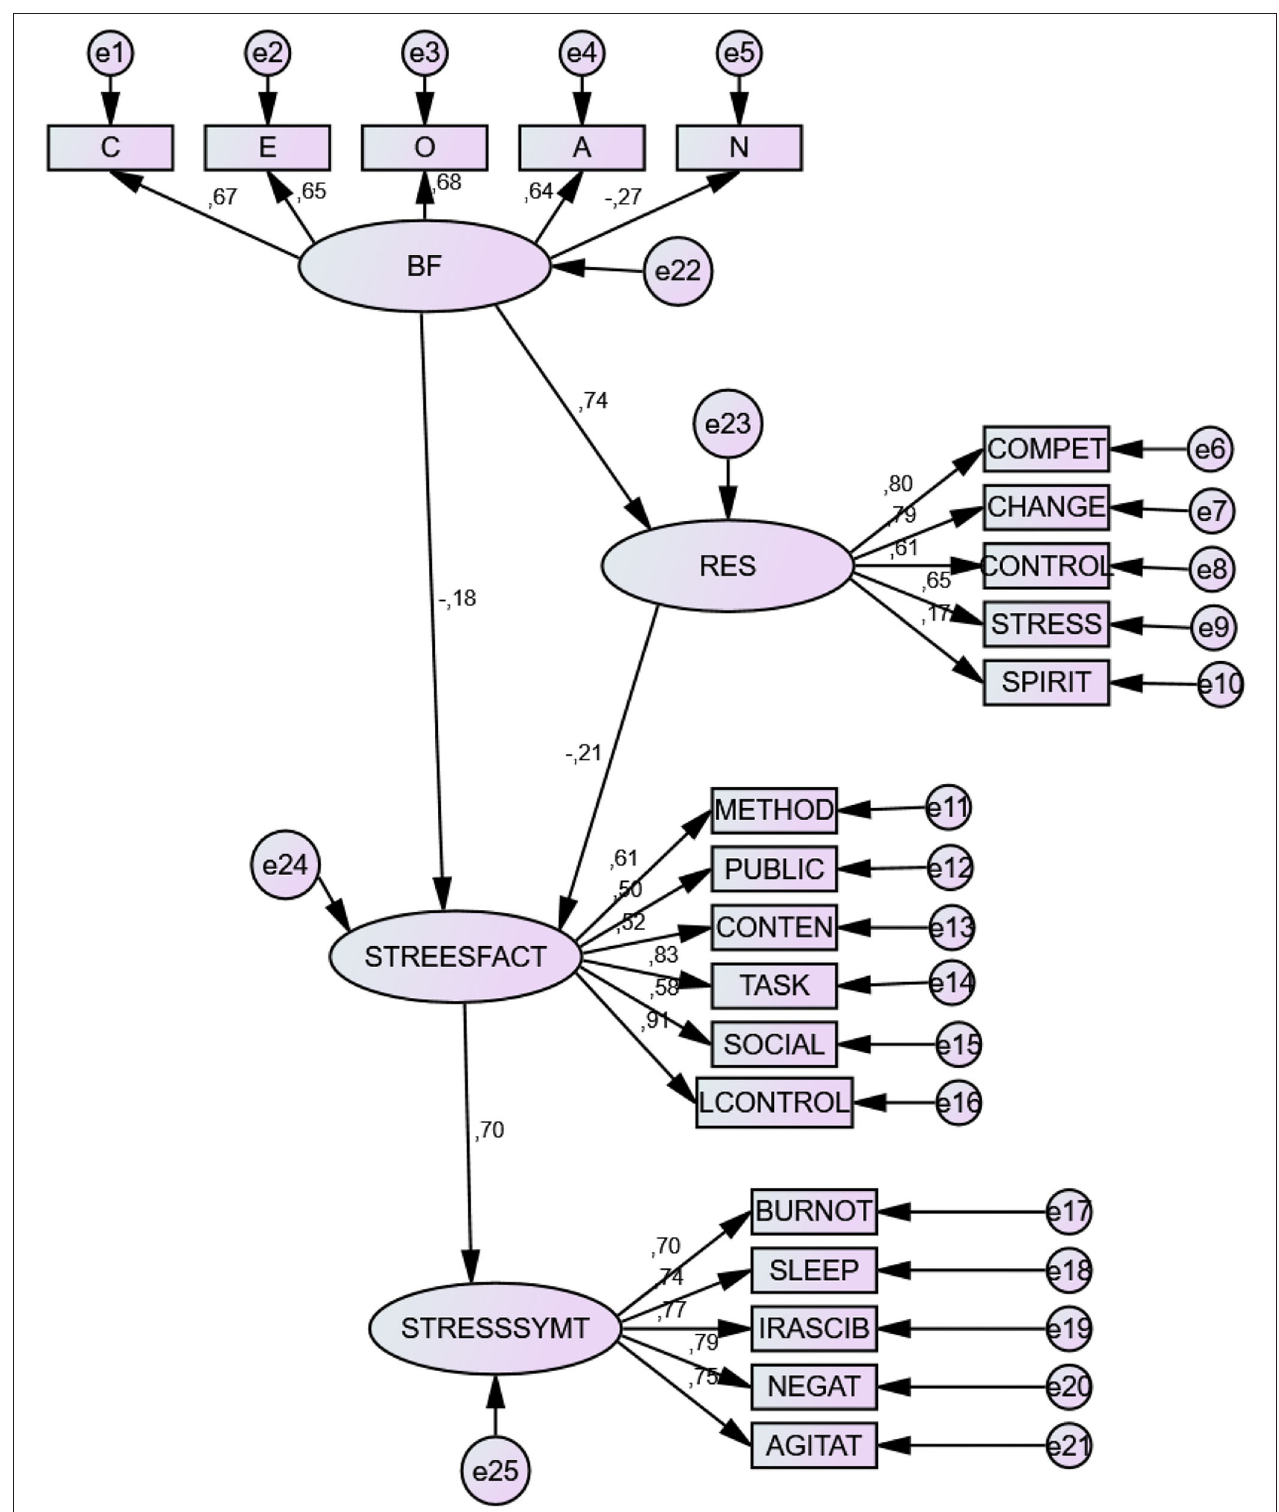
FIGURE 1 | Structural Prediction of variables in the second model. E, Extraversion; C, Conscientiousness; N, Neuroticism; O, Openness to Experience; A, Agreeability; RESIL, Resilience; STRESSFACT, Stress Factors; STRESSSYMNT, Stress symptoms.